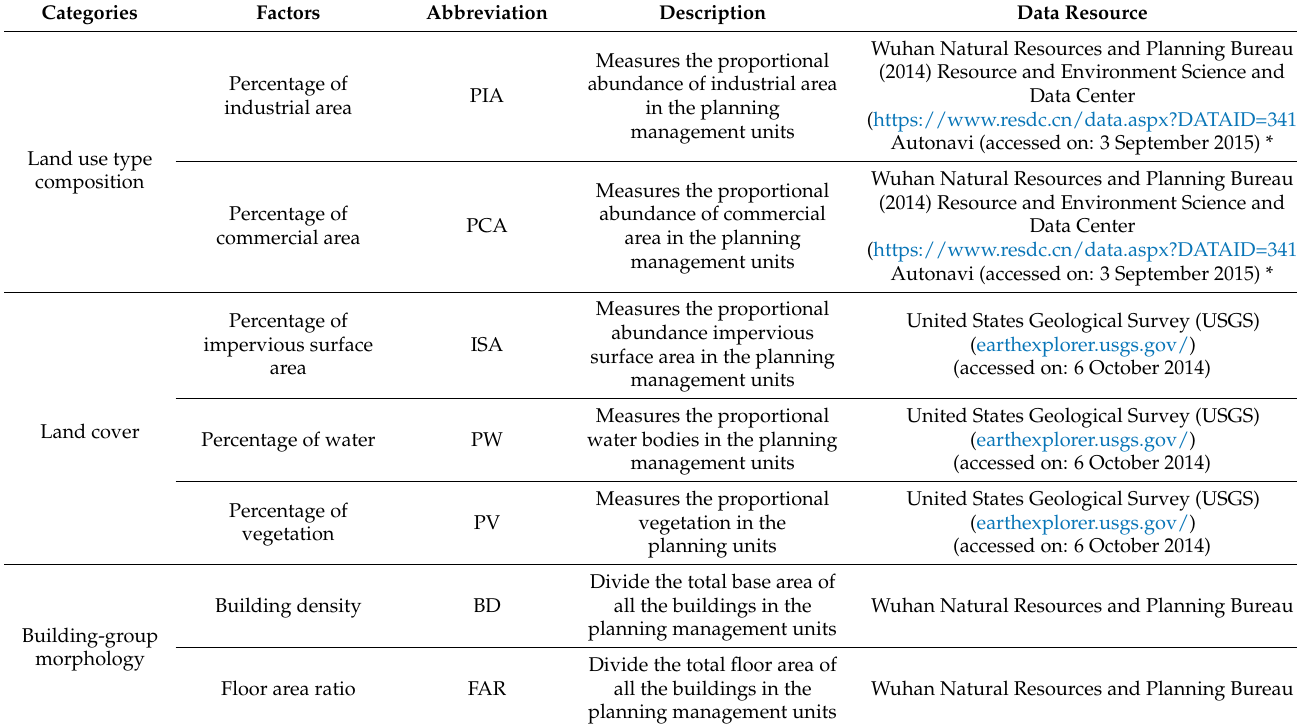
Table 1. The abbreviation and description of the land use